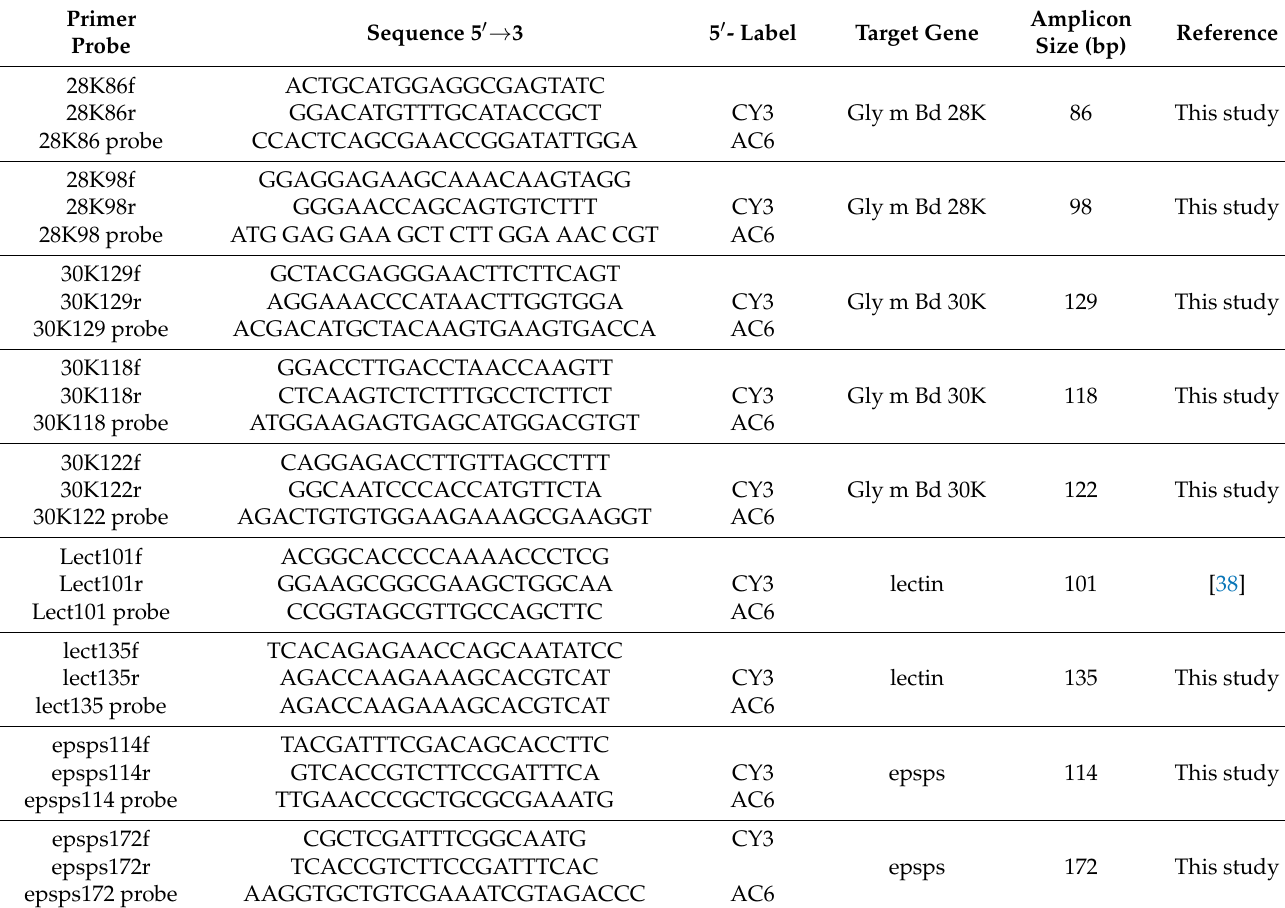
Table 1. PCR primers and DNA chip probes used in this